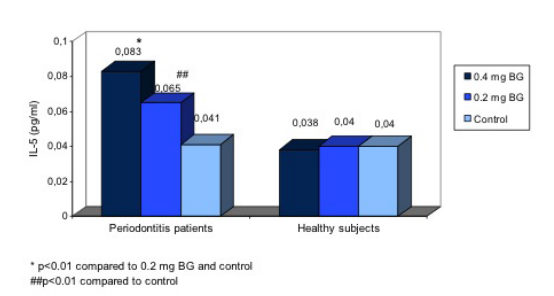
Figure 2. Comparison of IL-5 levels in stimulated leukocyte medium in periodontitis patient and healthy subject